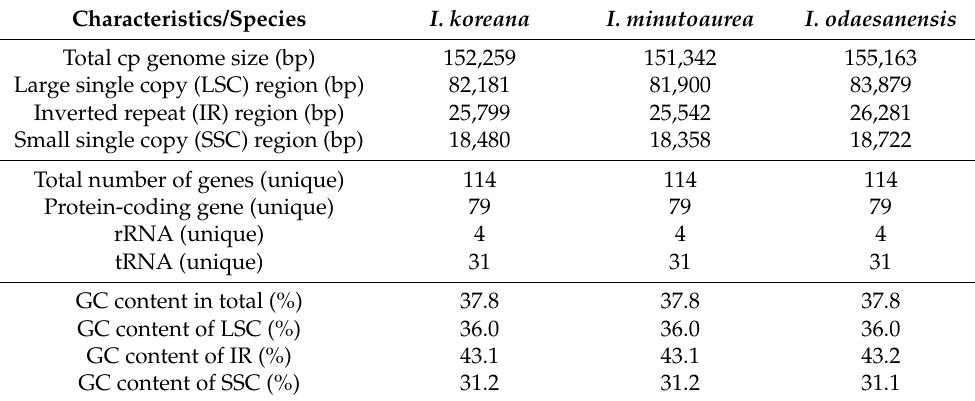
Table 2. Characteristics of chloroplast genomes of the three Iris species in Korea.